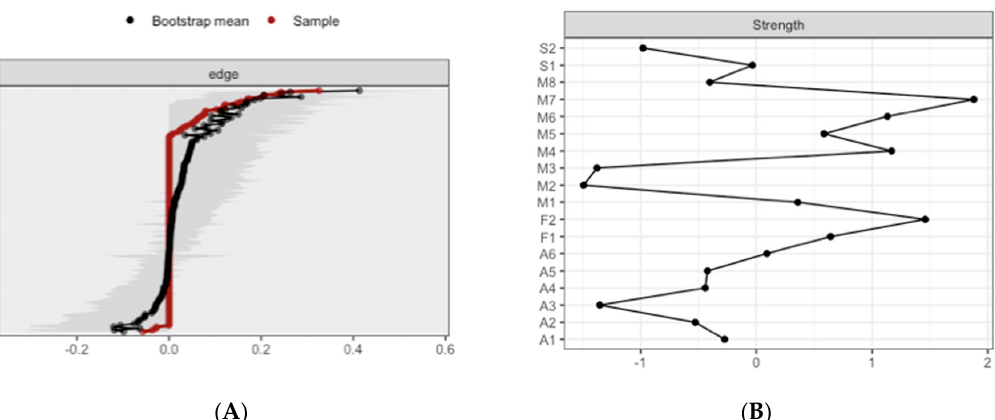
Figure 2. Estimated edge-weights for the estimated network and centrality of nodes. ( A ) Left: Bootstrapped CIs of estimated edge-weights for the estimated network. The red line indicates the sample values and the gray area the bootstrapped CIs. Each horizontal line represents one edge of the network, ordered from the edge with the highest edge-weight to the edge with the lowest edge-weight. ( B ) Right: Centrality of nodes within a network for all the subjects.